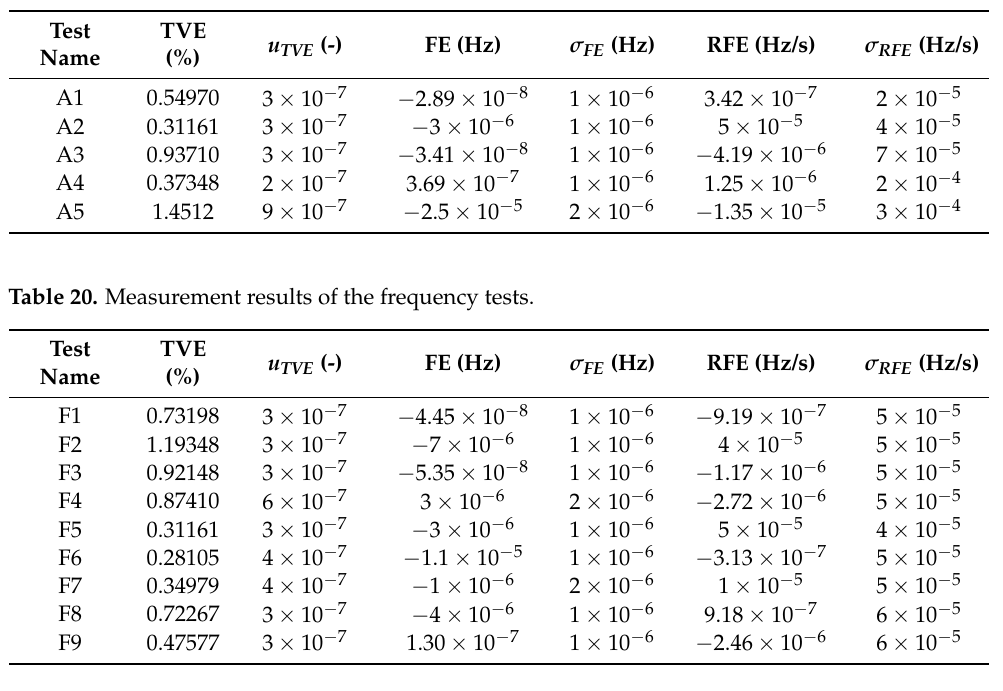
Table 19. Indices of the amplitude tests.